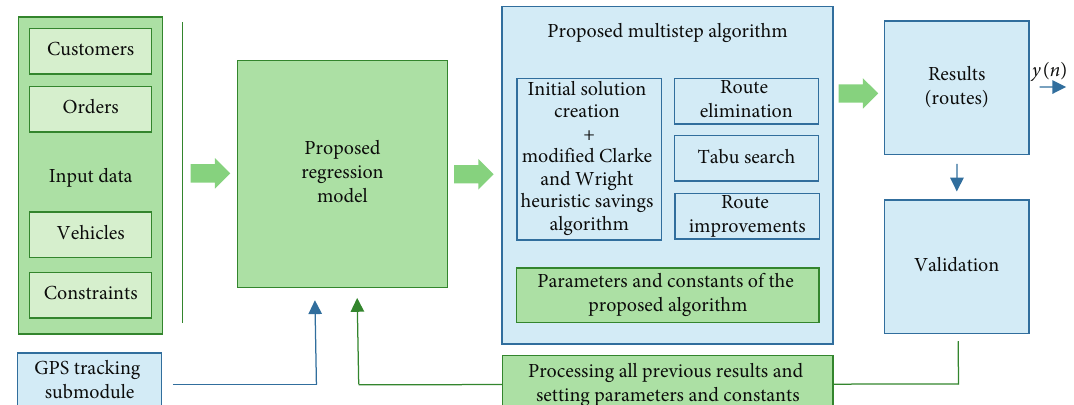
Figure 2: Control parameter adjustment approach using historical